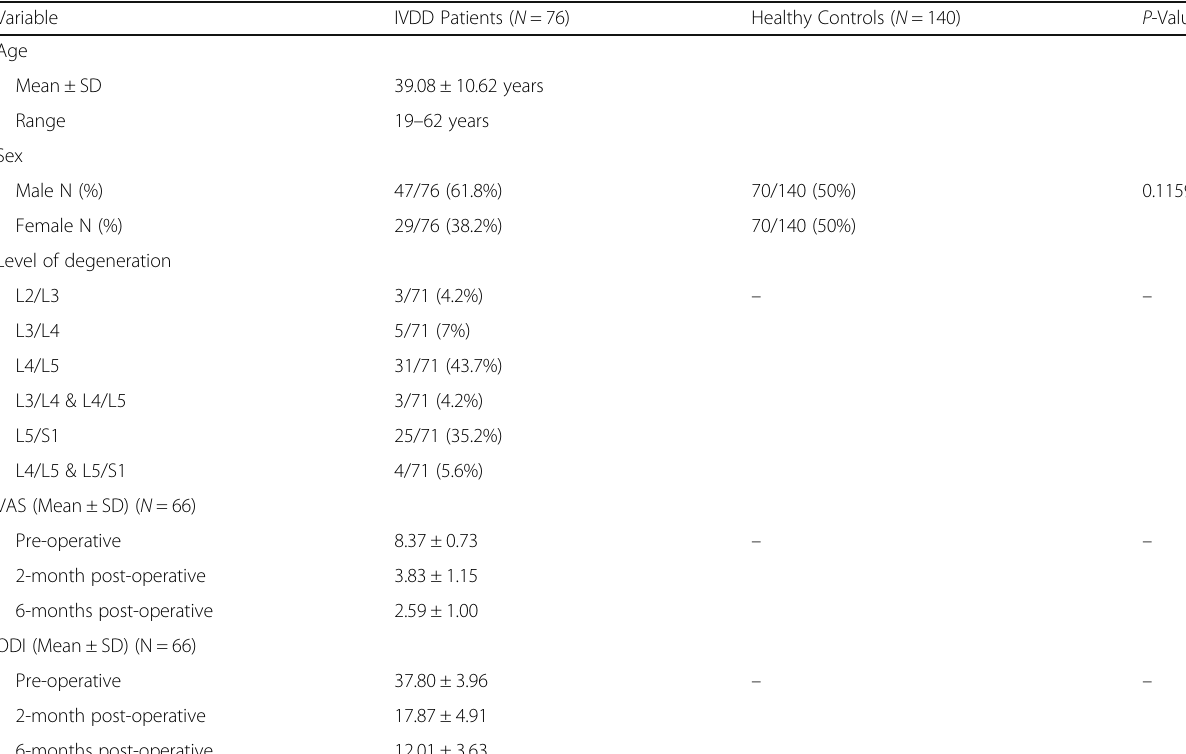
Table 1 Patients ’